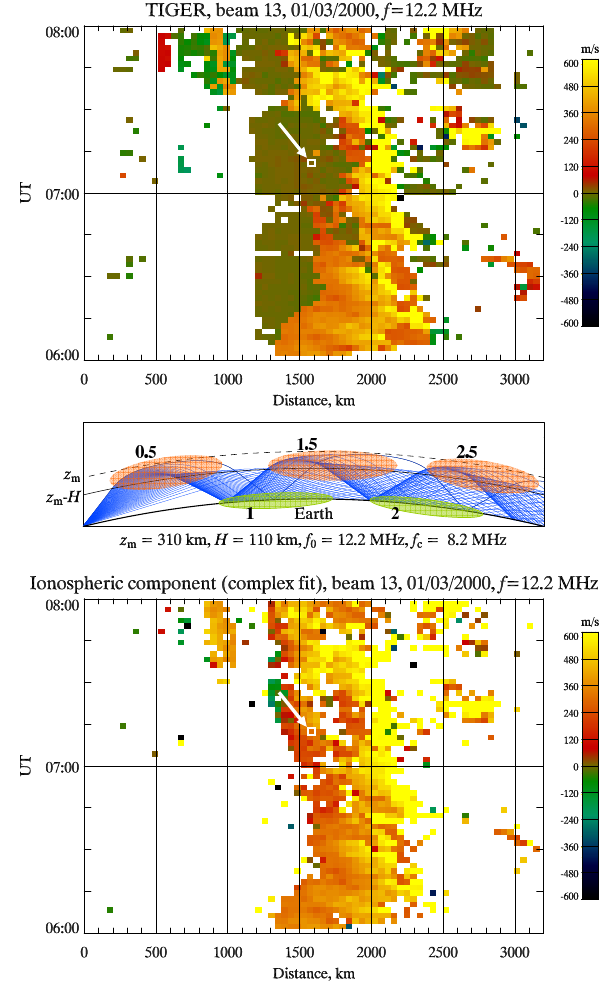
Fig. 1. Range-time map of line-of-sight velocity, V , from beam 13 of the TIGER radar (Tasmania) at 06:00–08:00UT, 1 March 2000 estimated using conventional FITACF package (top) and new two- component complex fit (bottom) accompanied by respective analyt- ical ray-tracing for the same distance range (middle). Light green and orange shading in the middle panel show areas of potentially intensive surface and ionospheric scatter, respectively. White rect- angles and arrows in the velocity panels correspond to the mixed- scatter ACF presented in Fig. 2.